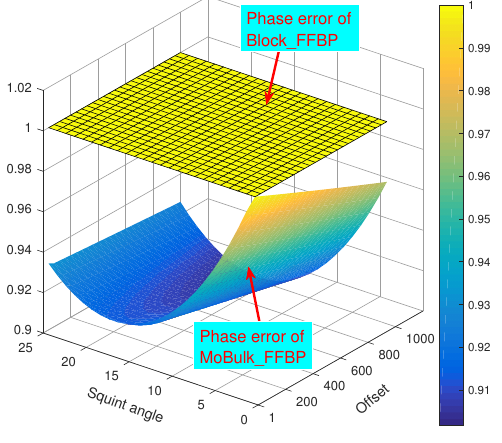
Figure 6. Comparative analysis of the residual phase error in Block_FFBP and MoBulk_FFBP. The top yellow plane indicates the residual phase error of Block_FFBP, which is equal to π and squint angel pair, the scene size changes to ensure that the maximum residual phase error is no more than π ). The offset axis is the range between the “new” and “old” 8